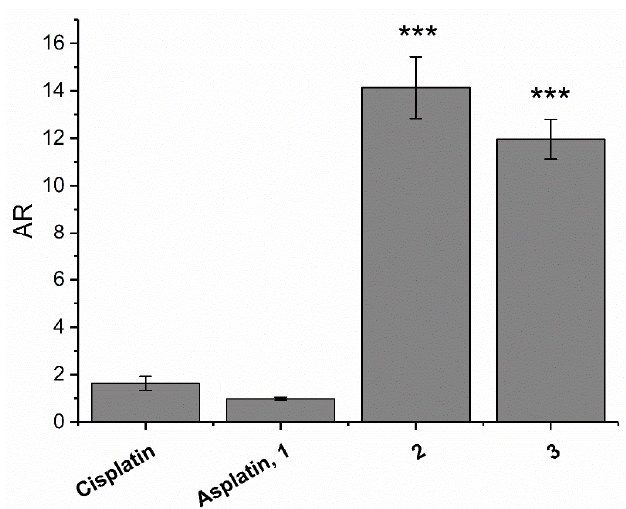
Figure 6. Accumulation ratio (AR) of cisplatin, 1 , 2 , and 3 , measured on A2780 ovarian cancer cells treated for 4 h with 10 µM concentrations of the Pt complexes. Data are means ± SEM of at least three independent replicates. Data are means ± SEM of at least three independent replicates and were compared by means of a one-way ANOVA analysis of a variance-Tukey test (no indication = not significant; *** p < 0.001 vs. cisplatin).